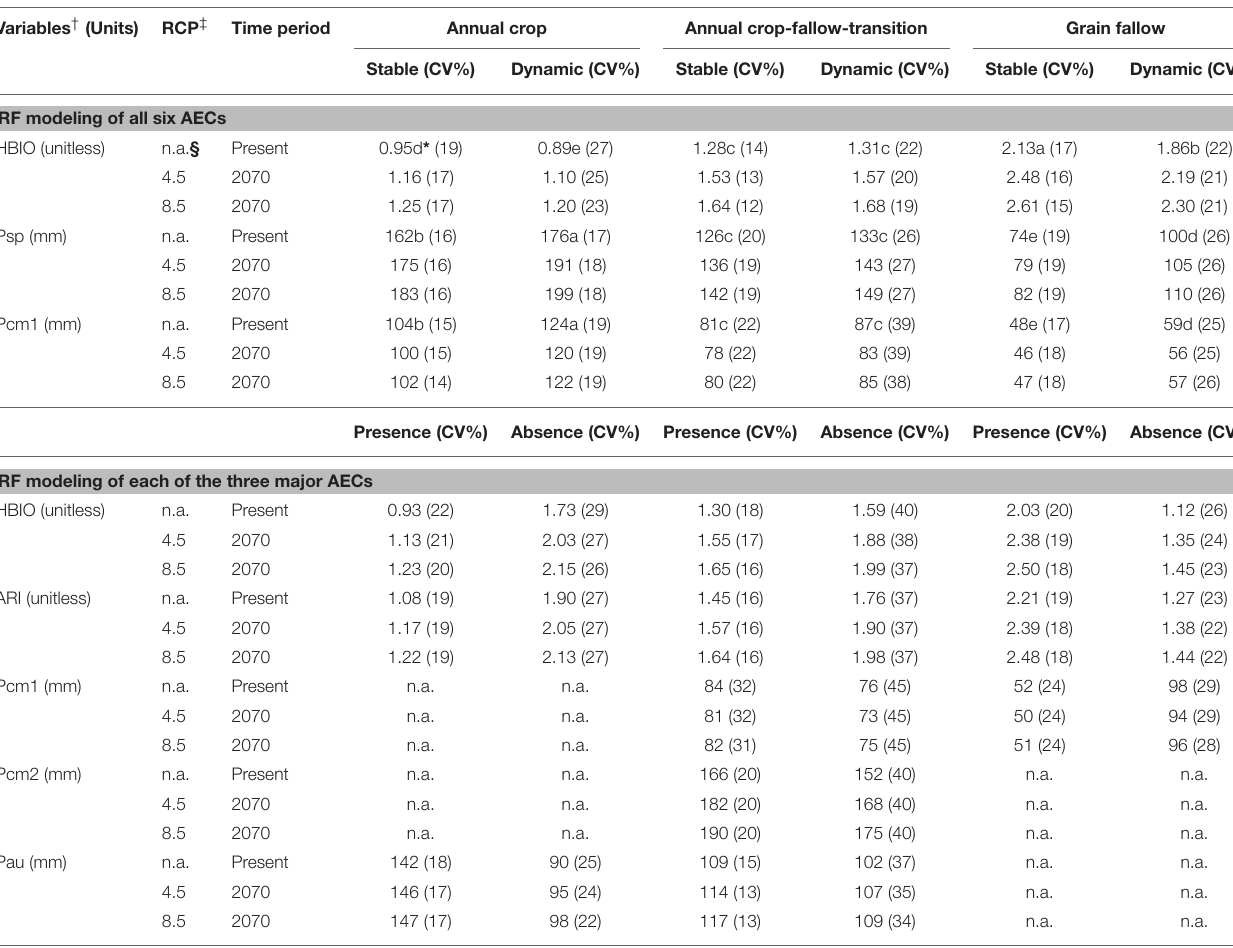
TABLE 4 | Spatial average and coefficient of variation (CV%) of bioclimatic variables used with Random Forest (RF) models for present time period (1981–2010) and their future (2070) predictions under two representative concentration pathway (RCP- 4.5 and 8.5) scenarios derived from 17 global climate